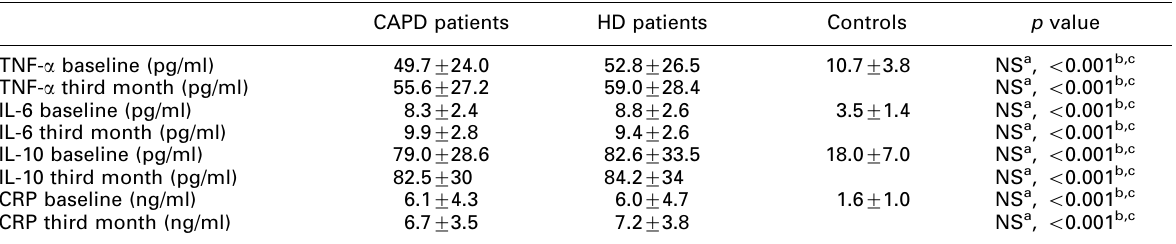
Table 2. Changes in serum CRP and serum cytokine levels in patients with CAPD and HD, and control groups during the study period CAPD